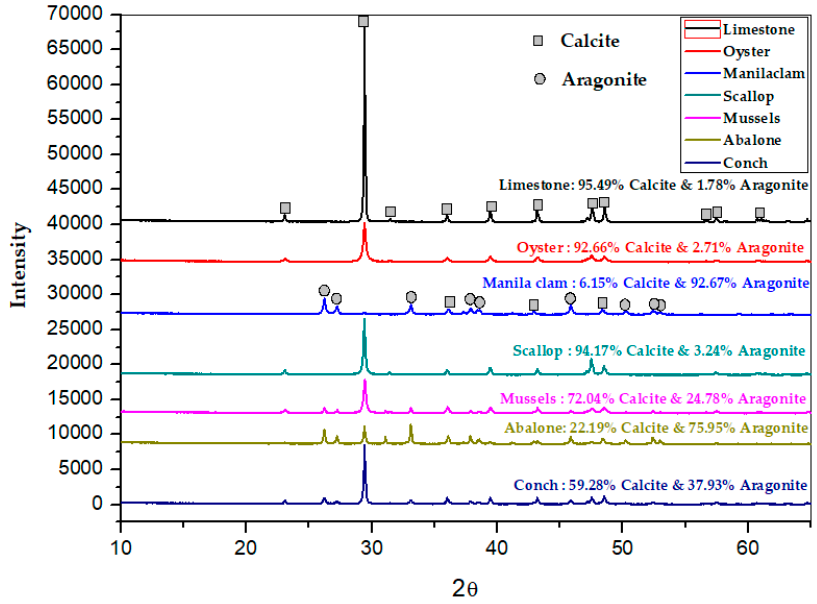
Figure 5. XRD patterns of raw mollusk shells with natural limestone.